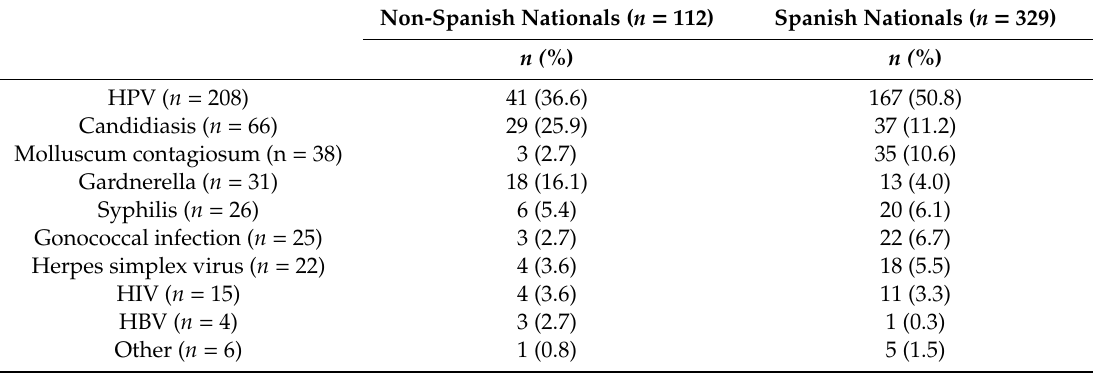
Table 2. Distribution of STIs in non-Spanish and Spanish populations ( n = 378). Granada, Spain, 2000–2014.